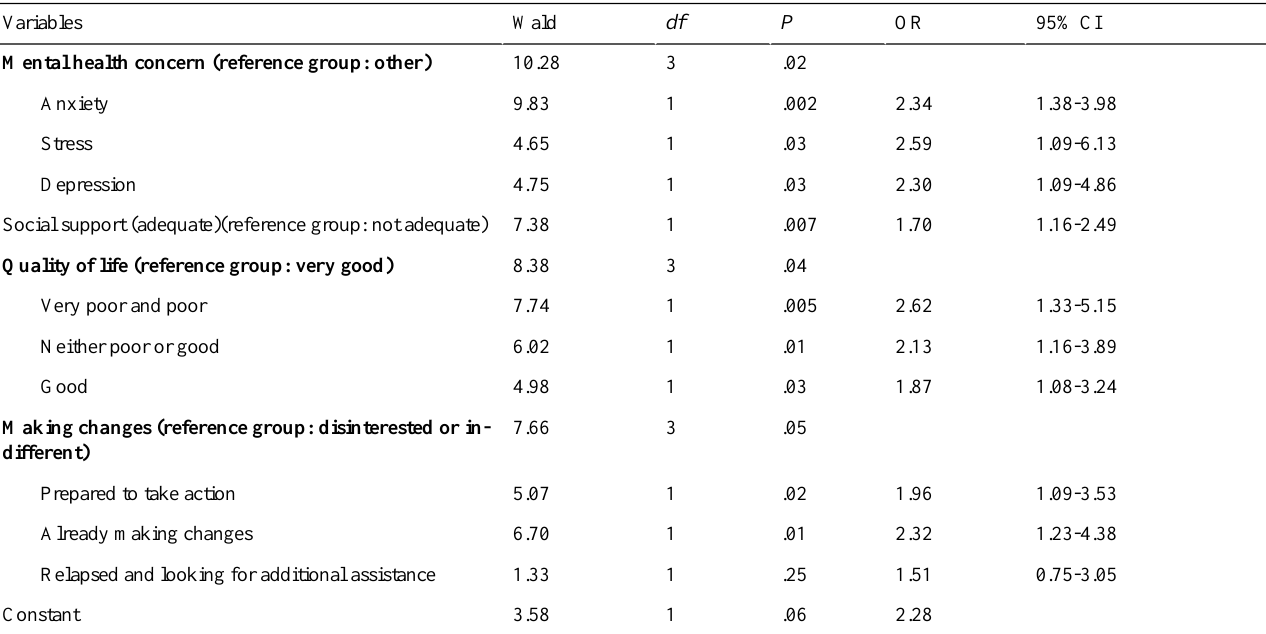
Table 4. Binary logistic regression model for formal treatment